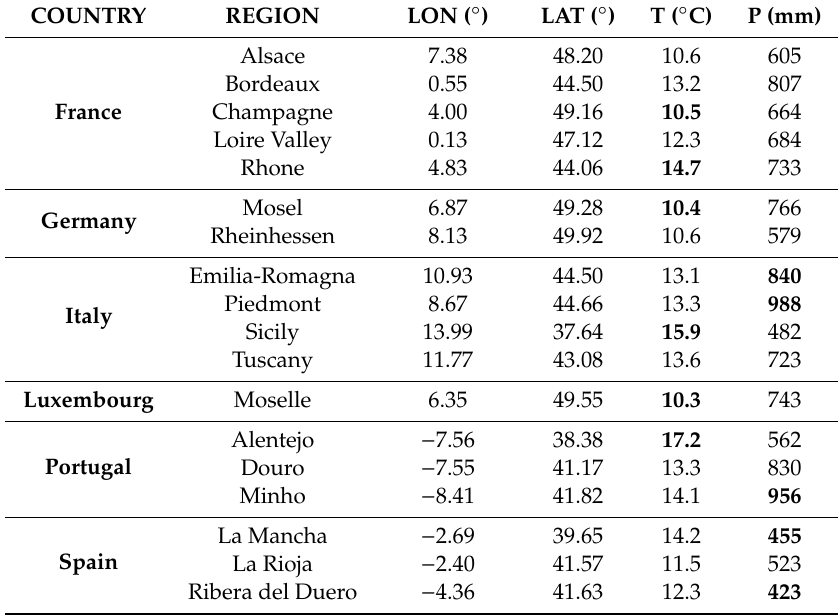
Table 1. Targeted winemaking regions (18 in total), with country and region designation, along with their centroid longitude and latitude, and area-means of annual mean temperature (T) and precipitation sum (P), calculated from the E-OBS dataset, version 19.0e, over the baseline period of 1986–2015. The three highest and lowest values are highlighted in